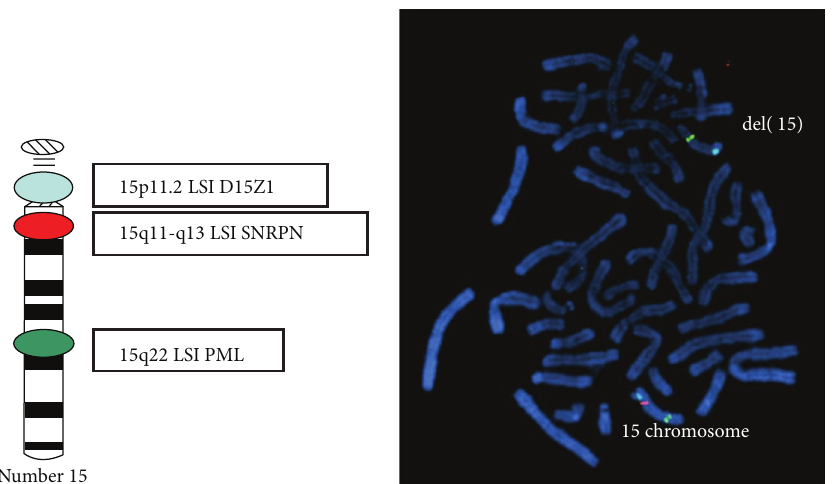
Figure 3: FISH analysis in metaphase with specific probes for 15 chromosome. Upper 15 chromosome with SNRPN deletion (del 15). D15Z1, SpectrumAqua; SNRPN, SpectrumOrange; PML, SpectrumGreen.